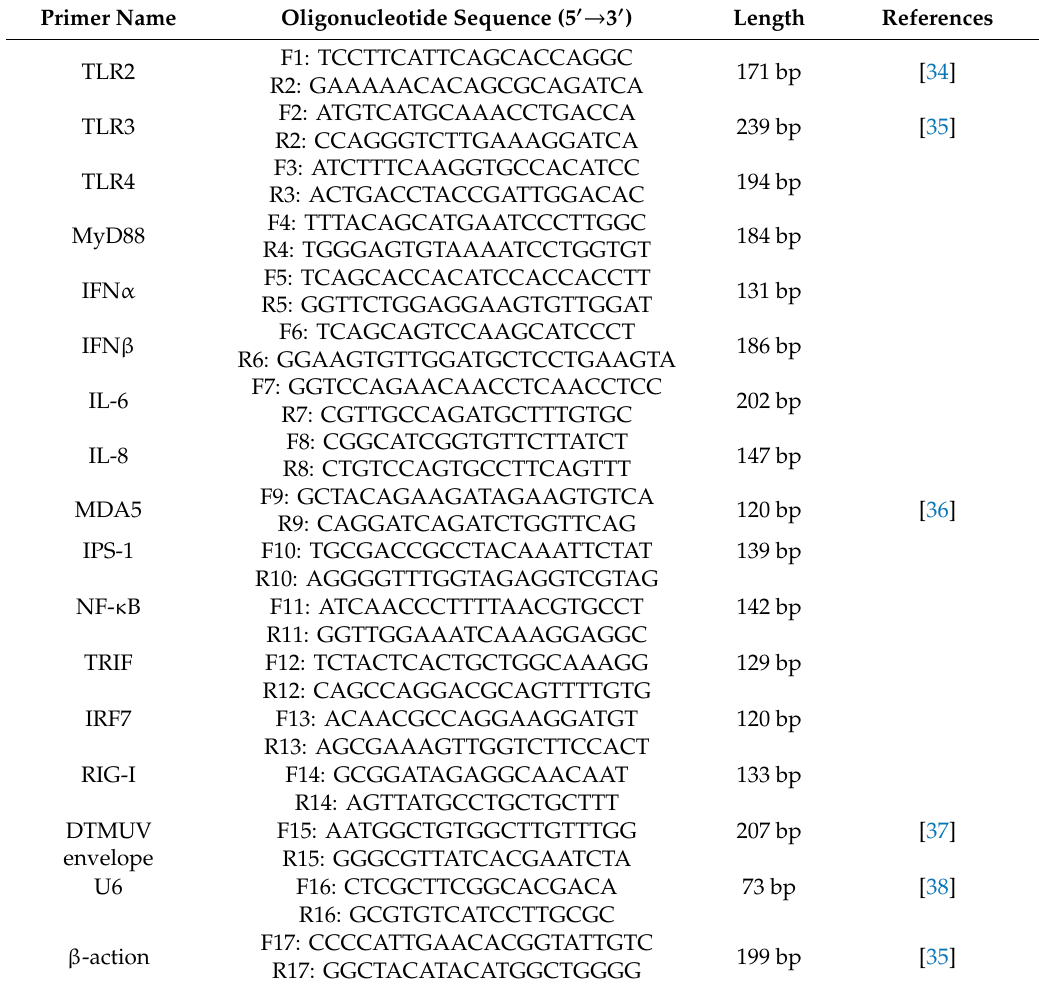
Table 1. Primers used in this